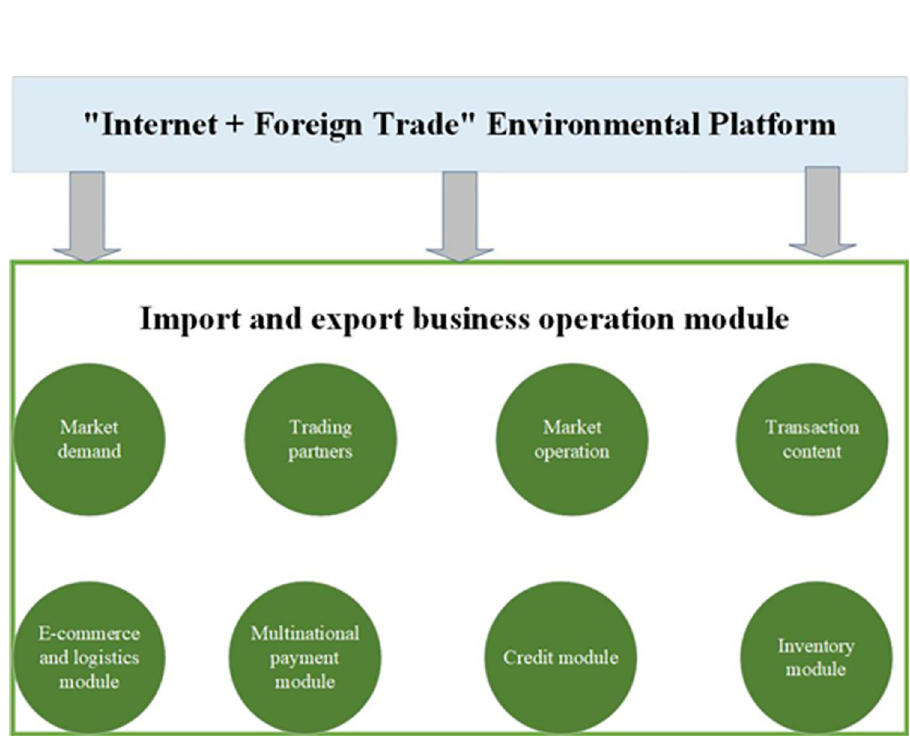
Fig 2. Business operation module of controllable relevance big data mining model of foreign trade goods sales under the background of "Internet plus foreign trade".